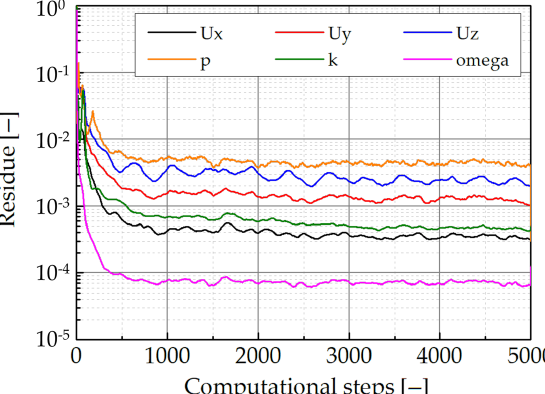
Figure 14. Figure showing the variations in the residues of each velocity component ( U x , U y , U z ), pressure ( p ), turbulence energy ( k ), and omega for the computational